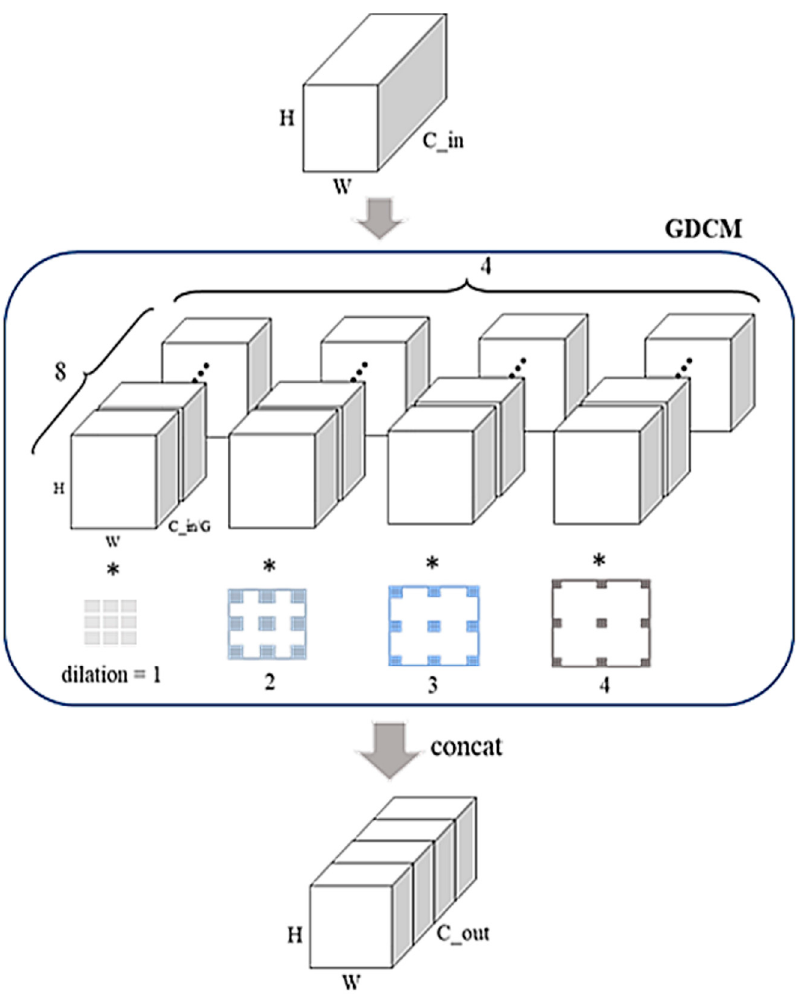
Figure 3. Proposed GDCM in which all 32 grouped convolutions are applied in a convolution layer. All are divided into four subgroups that apply different dilation convolutions. The value of a dilation parameter is established to be 1, 2, 3 or 4 according to the group, and the final output is derived via